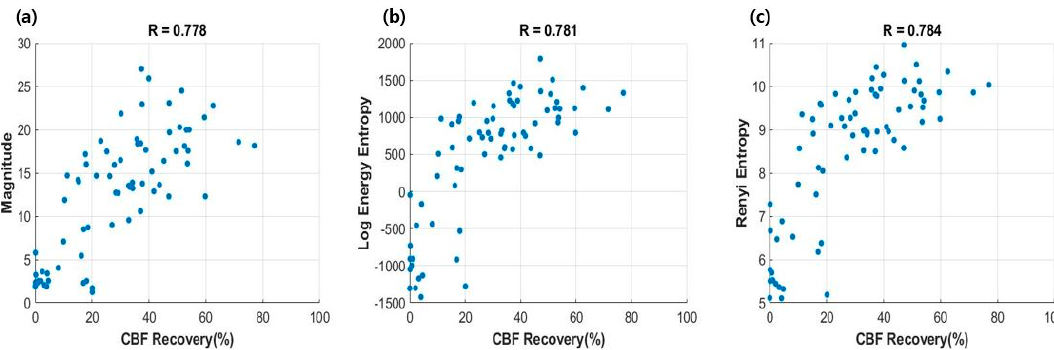
Figure 4. Scatter plots between EEG parameters and the recovery of CBF. Correlation coefficients were denoted above the plots: ( a ) magnitude; ( b ) log energy entropy; ( c ) Rényi entropy .